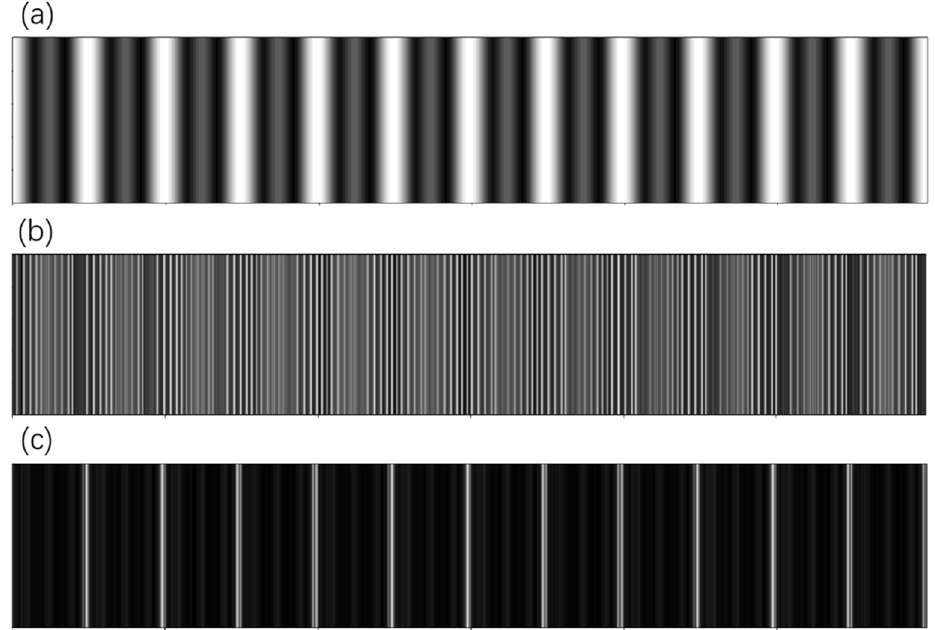
Figure 4. ( a ) reconstruction with only the first harmonic; ( b ) reconstruction with the wrong frequency selection; ( c ) reconstruction with all harmonics of frequency T = 12.